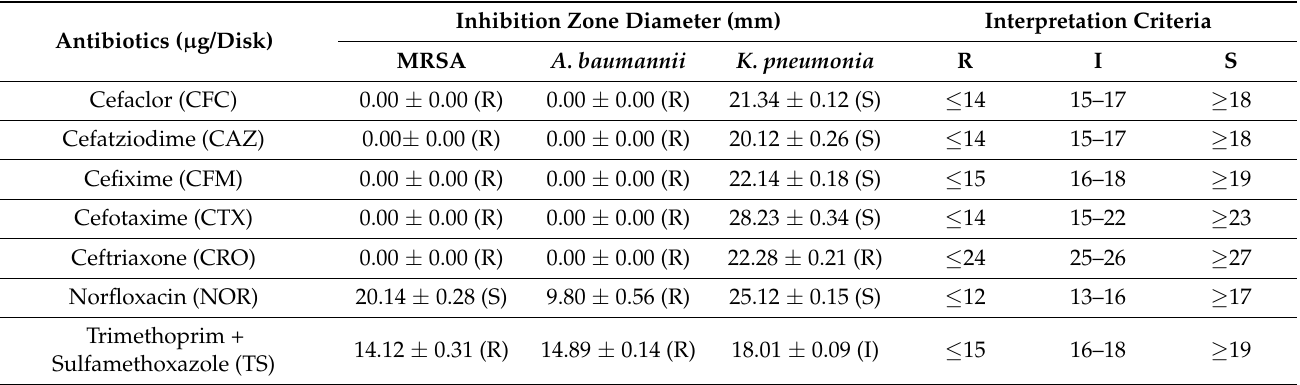
Figure 9. Antibacterial susceptibility testing of the tested bacterial strains against different antibiotics. Table 2. Antibiotic susceptibility testing of the tested bacterial strains to different antibiotics.